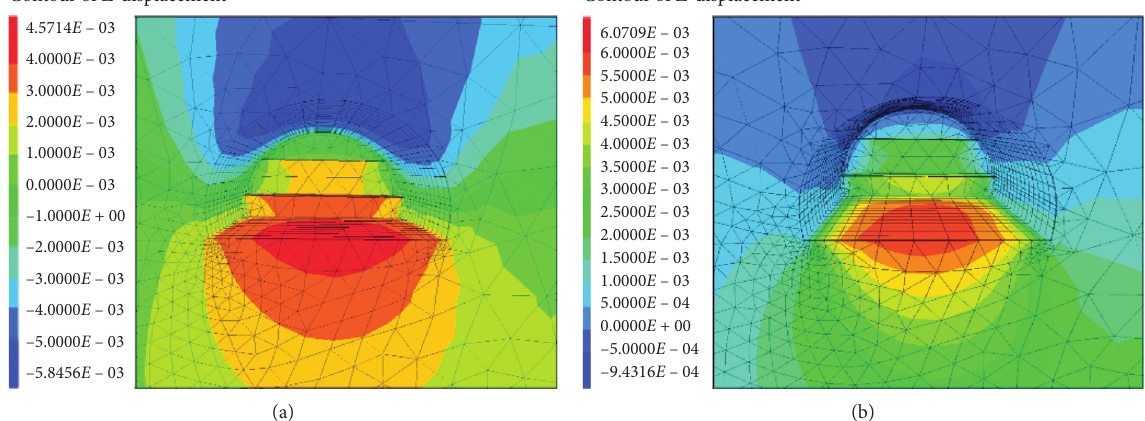
Figure 8: Contour of z-displacement: (a) condition 1; (b) condition 2.